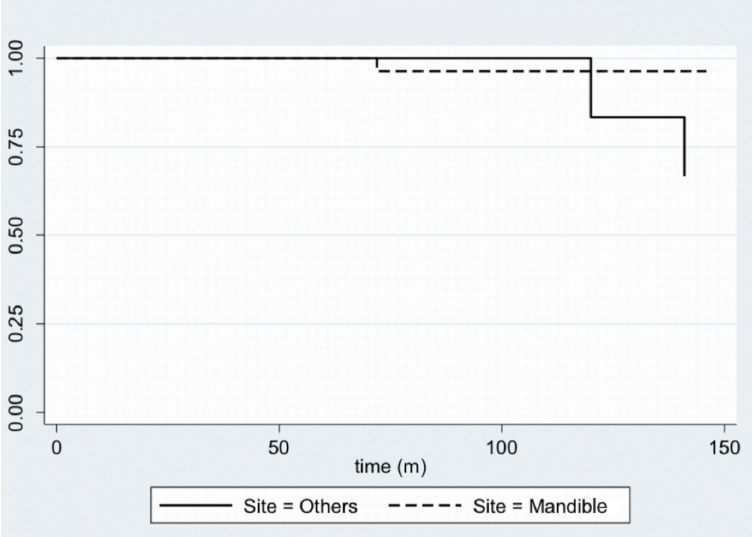
Figure 3. Kaplan–Meier plot for disease-free survival, stratifying the sample by site. Table 6. Univariate and multivariate logistic